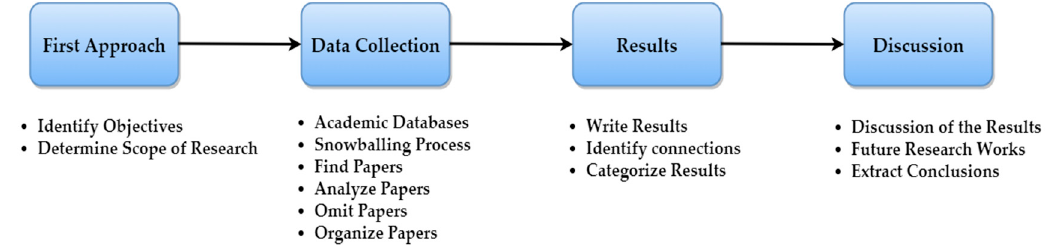
Figure 3. Stages of the present literature review.